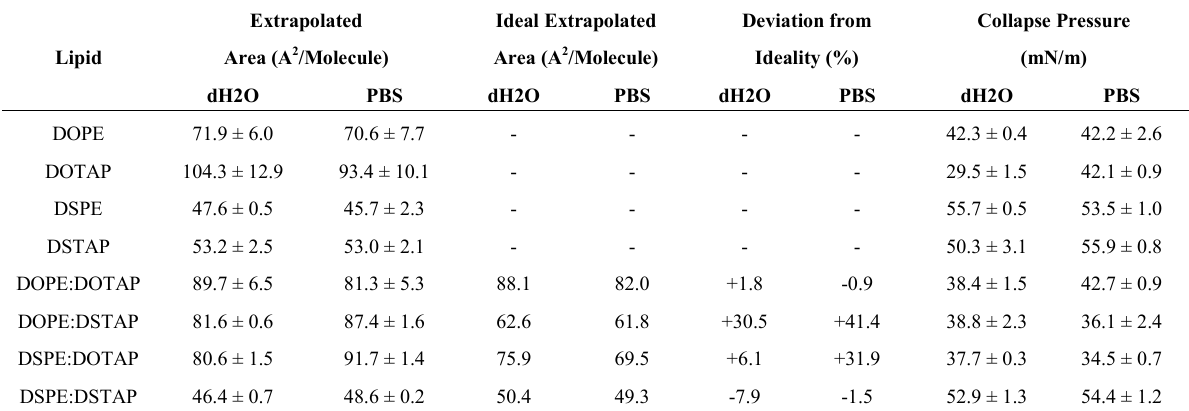
Table 1. The experimental extrapolated area and area compressibility of mixed and pure monolayers at the air/aq media interface at 20 °C in dH denote mean ± SD, n =